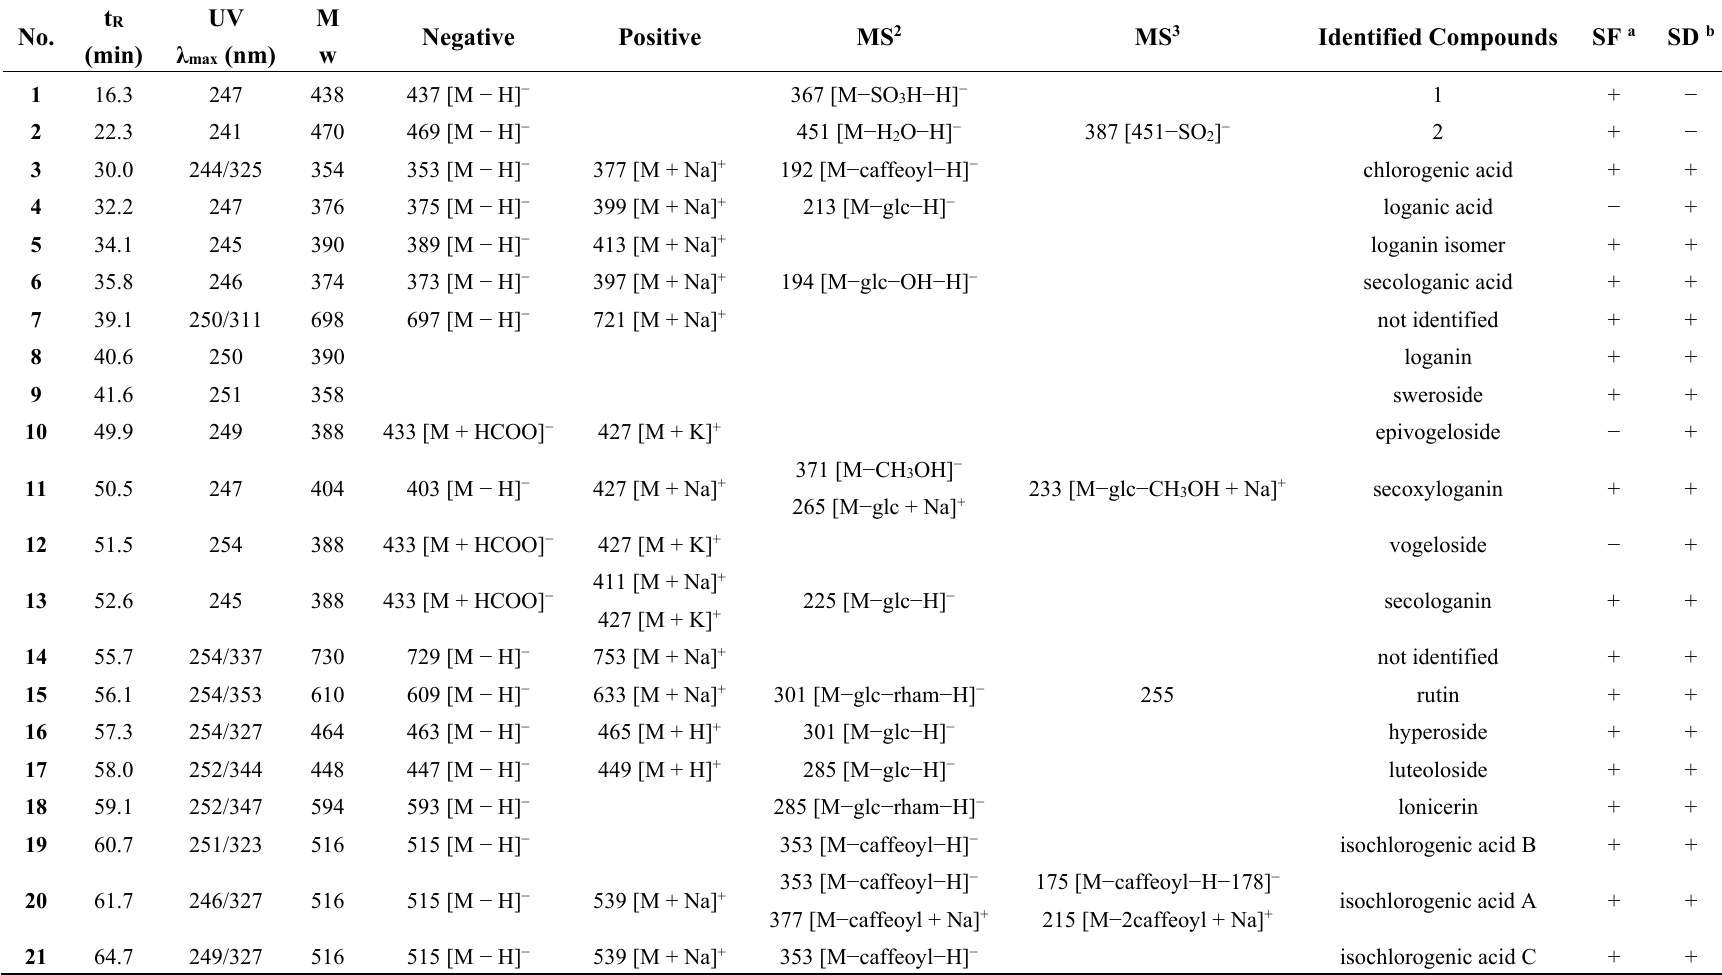
Table 1. The identified compounds in sulfur-fumigated and sun-dried LJF samples by HPLC and LC-MS n